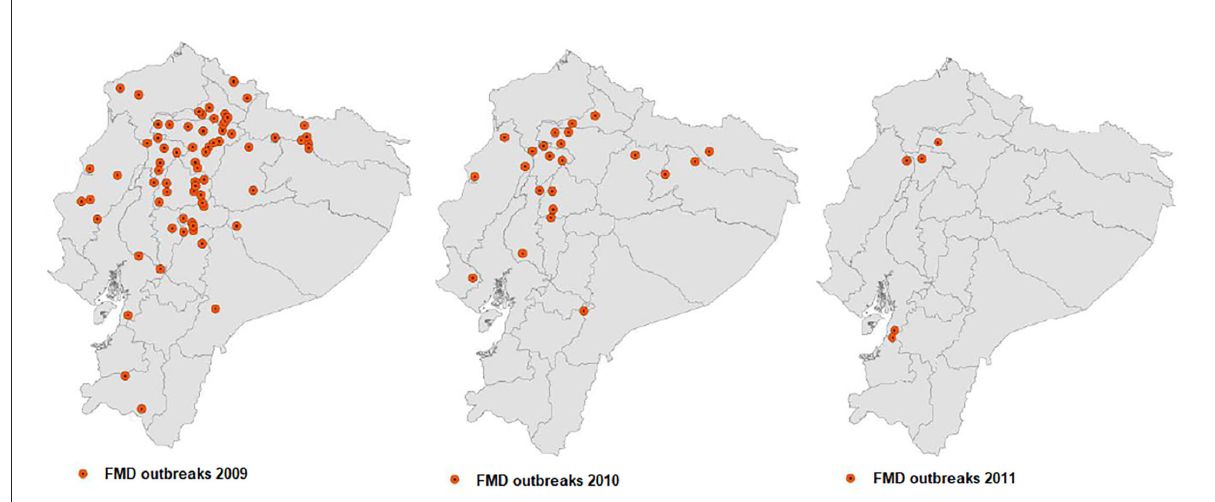
FIGURE3 Location of the FMD outbreaks in Ecuador: 109 reported in 2009, 42 in 2010, and 5 in